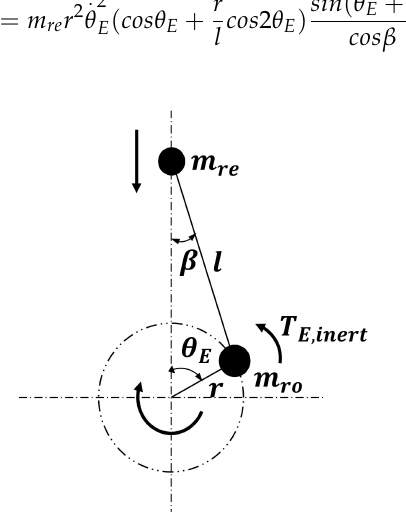
Figure 5. The equivalent mass of crank-connecting